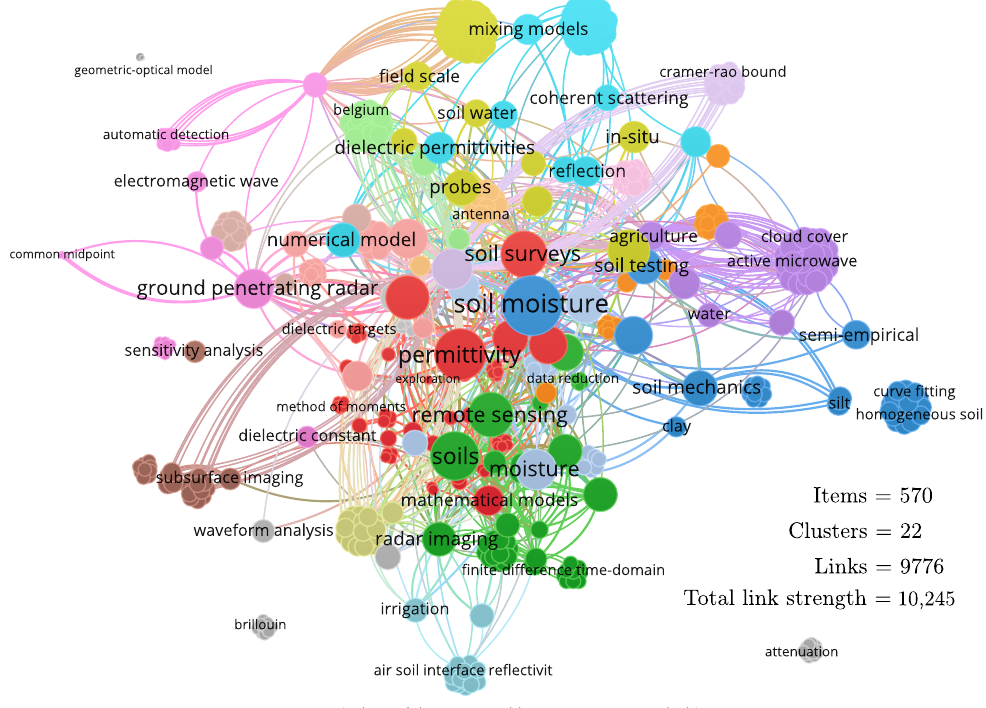
Figure 1. Keywords co-occurrence bibliometric analysis of the words (soil, dielectric models, and pen- etration depth). The keywords are from more than 45 research publications (from the Scopus database indexed till 30 August 2022). There are about 570 items (i.e., words) that get clustered into 22 clusters (shown in different colors) and 9776 links (indicated in curve